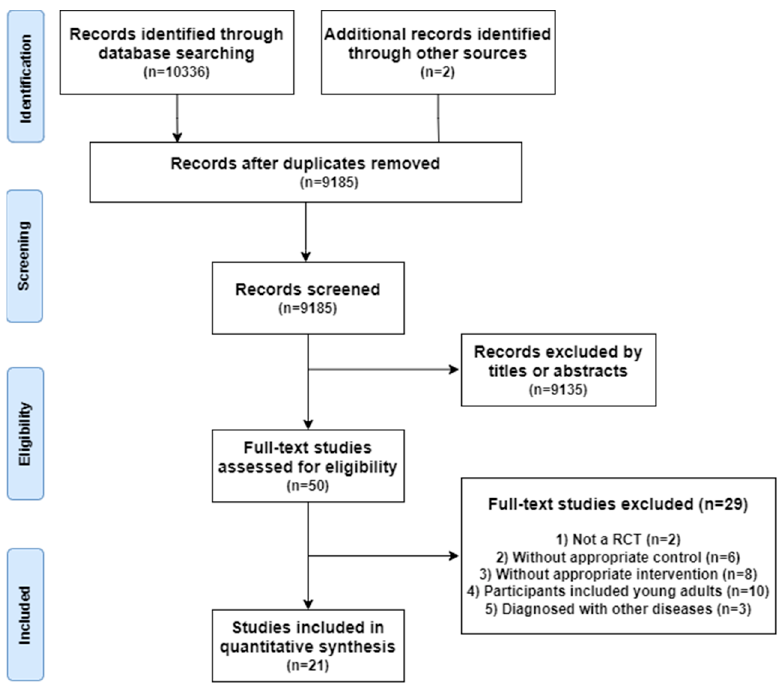
Figure 1. Flowchart representing the selection progress.